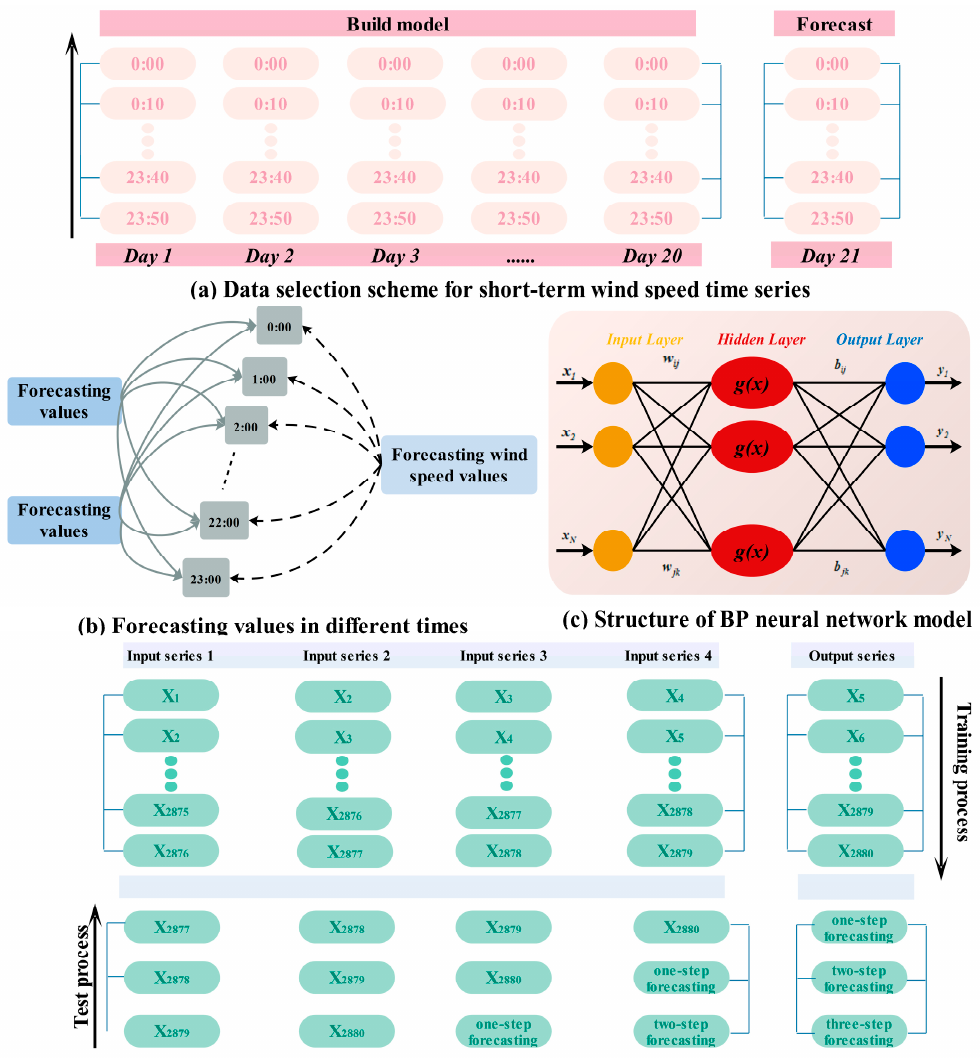
Figure 4. Data selection scheme for three indicators in the electrical power system.